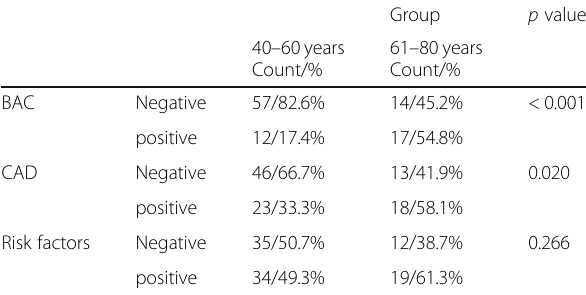
Table 2 Comparison between the two groups